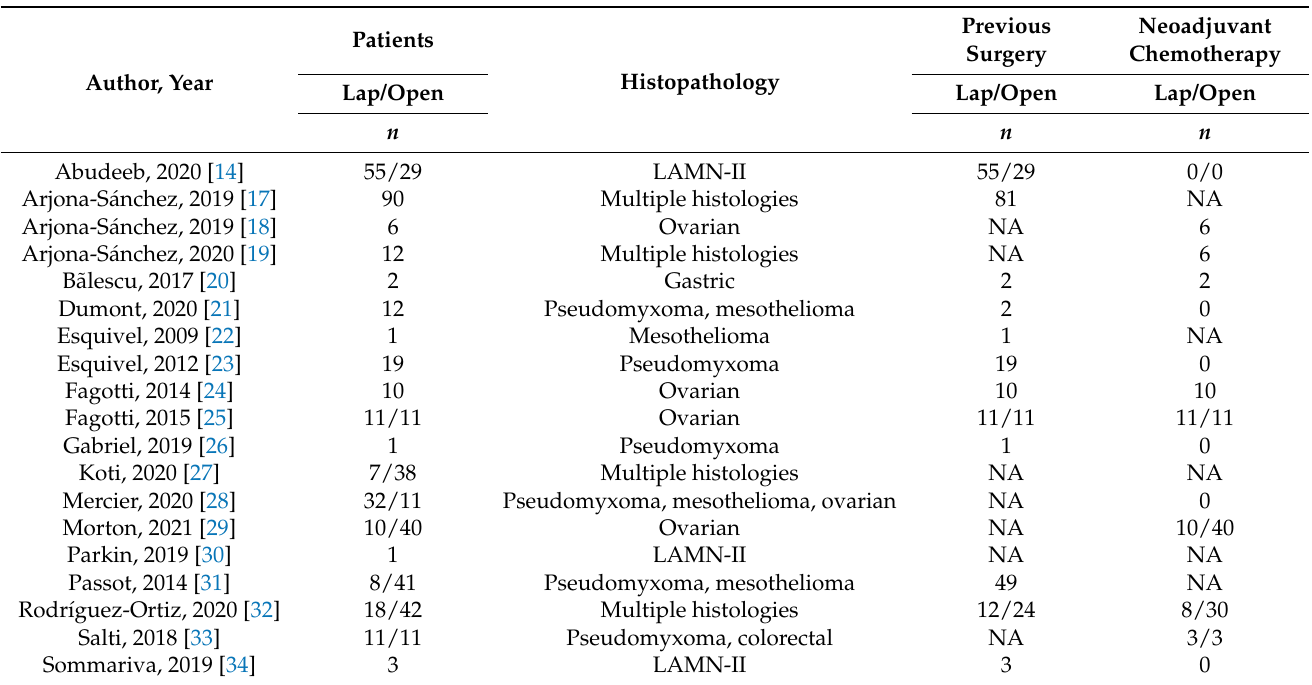
Table 2. Preoperative